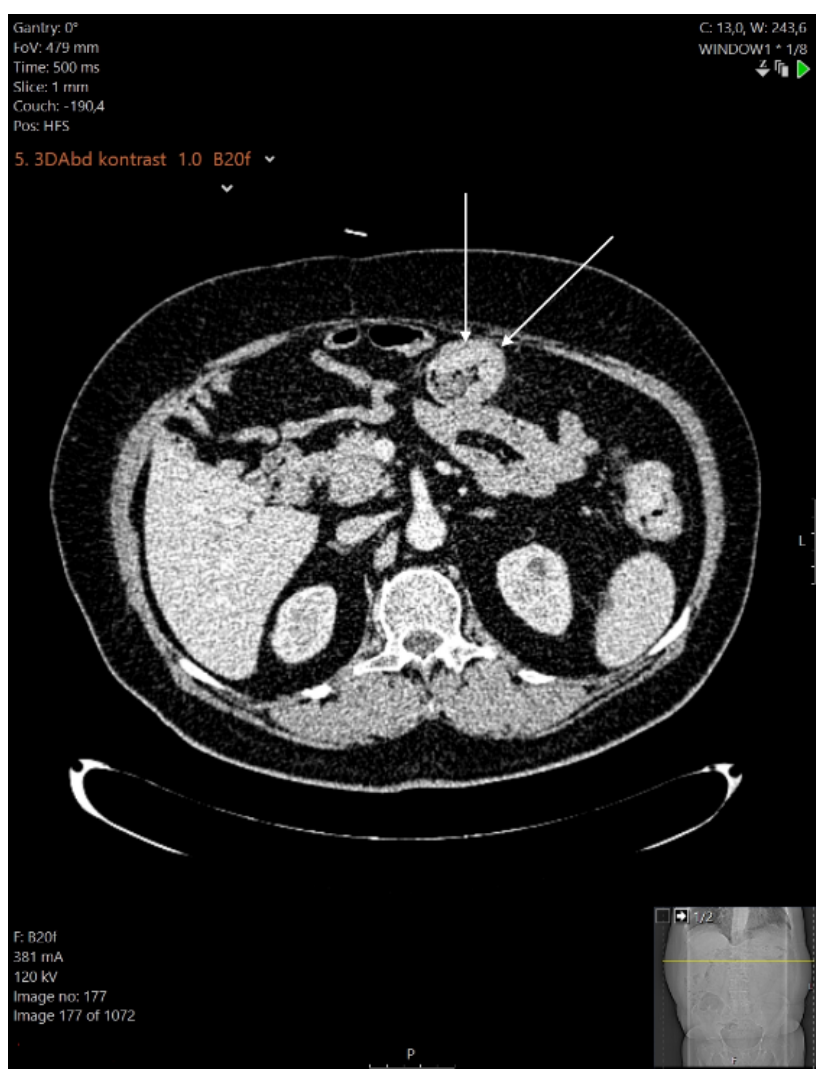
Figure 4. Abdominal multislice CT scan: colonic wall thickening with giant inflammatory polyps.